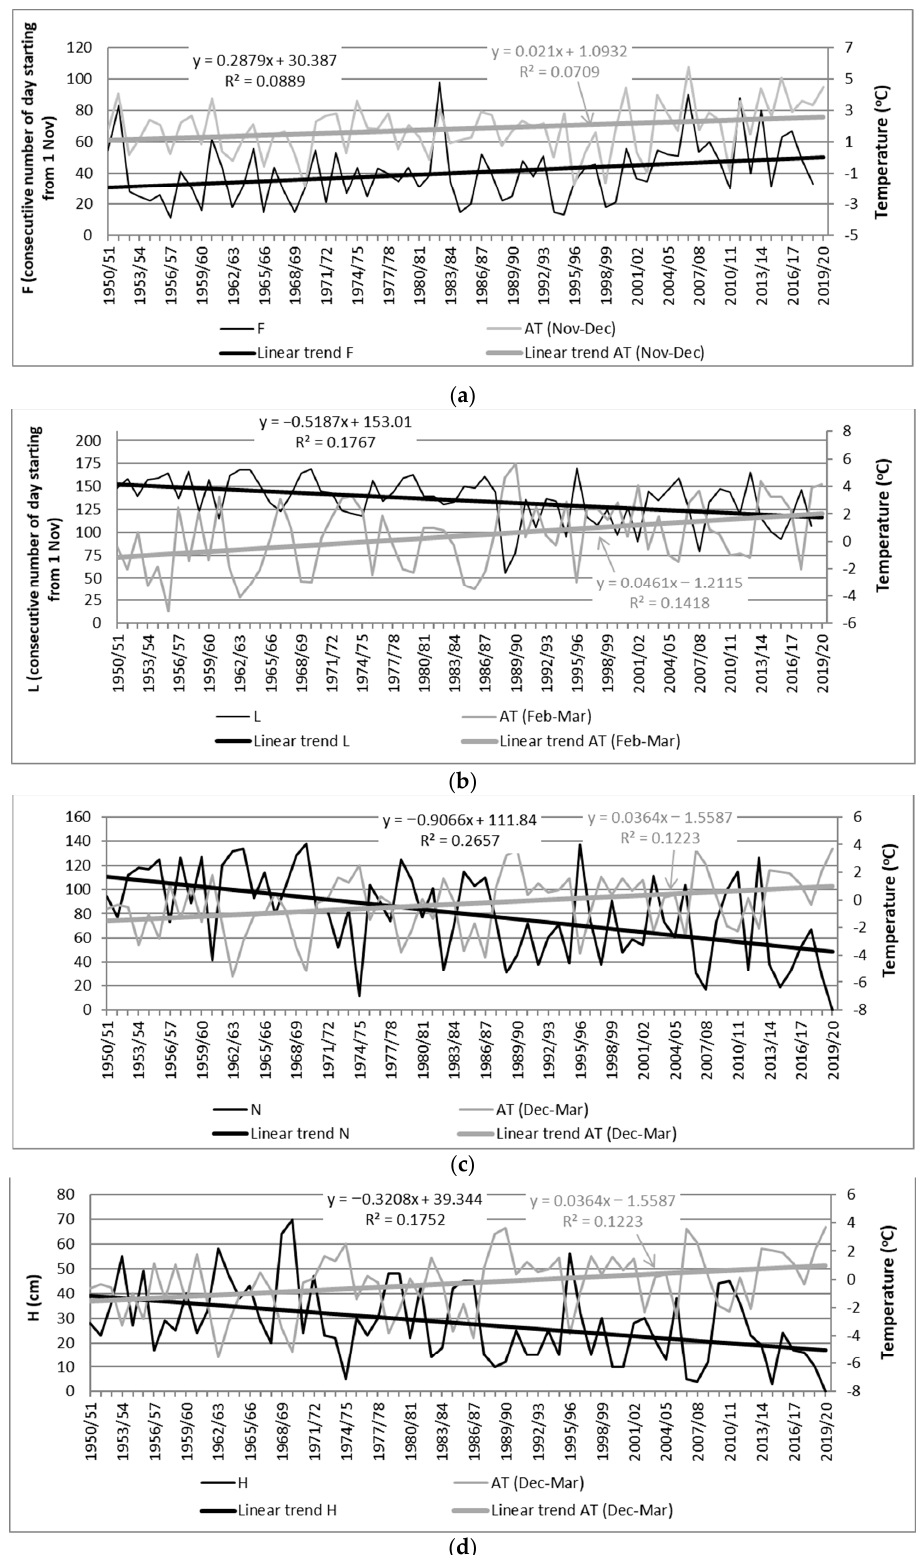
Figure 9. Variations and trend lines for: ( a ) first ice occurrence (F); ( b ) last ice disappearance (L); ( c ) the number of days with ice (N); ( d ) maximum ice thickness (H) on Vistula Lagoon, and air temperature (AT) from selected months (Nov–Dec, Feb–Mar, and DecMar), along with the regression line equations and determination coefficient R 2 through the period